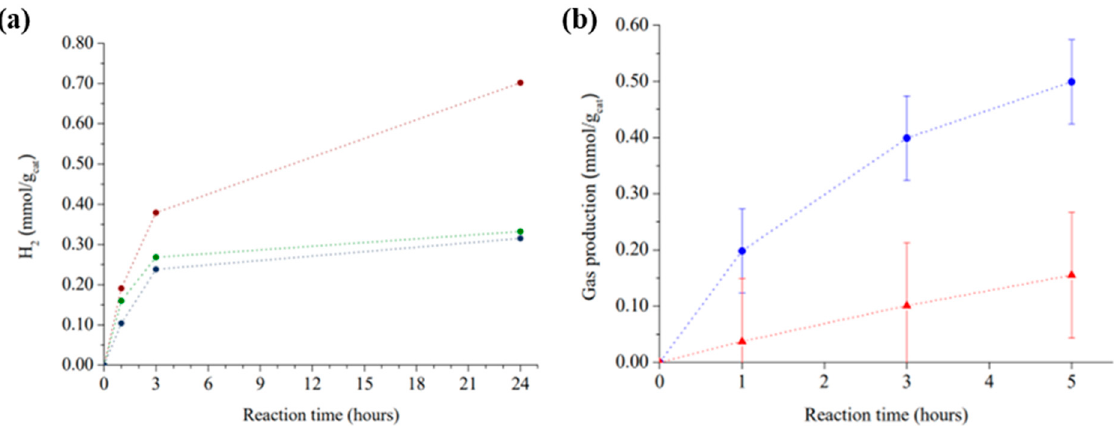
Figure 5. ( a ) PWS at 30 °C under simulated sunlight in presence of: COP–1 ( ● ), COP–2 ( ● ) or COP–3 ( ● ). ( b ) PWS of COP–3, generation of hydrogen ( ● ) and oxygen ( ▲ ).